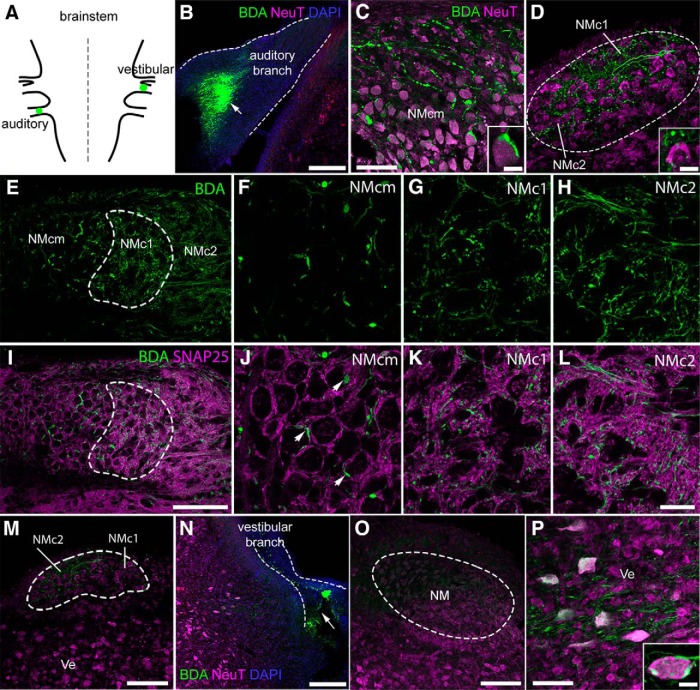
NMc1 and NMc2 receive excitatory inputs from auditory nerve fibers. A, Schematic drawing shows injection sites of BDA in auditory and vestibular branches of the eighth nerve. See details in Materials and Methods. B, The injection site (white arrow) in the cochlear branch outlined by dashed lines. C, BDA-labeled axons and terminals in NMcm. The inset shows the end bulb morphology of a labeled terminal. D, BDA-labeled axons and terminals in NMc1 and NMc2. The images were taken from a section at the level of Fig. 1E. The inset shows the bouton-like morphology of labeled terminals. E–H, BDA-labeled axons and terminals in NMcm, NMc1, and NMc2 at the level of Fig. 1F. NMc1 is outlined by dashed line. F–H are closer views of NMcm (F), NMc1 (G), and NMc2 (H). I–L, Double-labeling of BDA (green) and the excitatory synaptic marker SNAP25 (magenta). J–L are closer views of NMcm (J), NMc1 (K), and NMc2 (L). Arrows in J indicate a number of BDA-labeled end bulbs double-stained with SNAP25. M, No labeling was observed in vestibular nuclei after injections in the cochlear branch. N, The injection site (white arrow) in the vestibular branch outlined by dashed lines. O, No labeling in NM after the injection in N. P, BDA-labeled terminals in the vestibular nucleus ventral to NM. Inset shows a labeled terminal around a vestibular neuron. Abbreviations: BDA, dextran; NeuT, NeuroTrace; Ve, vestibular nucleus; NA, nucleus angularis; NL, nucleus laminaris. Other abbreviations: see Fig. 1. Scale bars = 100 μm in B, M, N, O, and P; 50 μm in C, D; 100 µm in I (applies to E and I); 20 μm in L (applies to F–H and J–L); and 10 μm in insets.